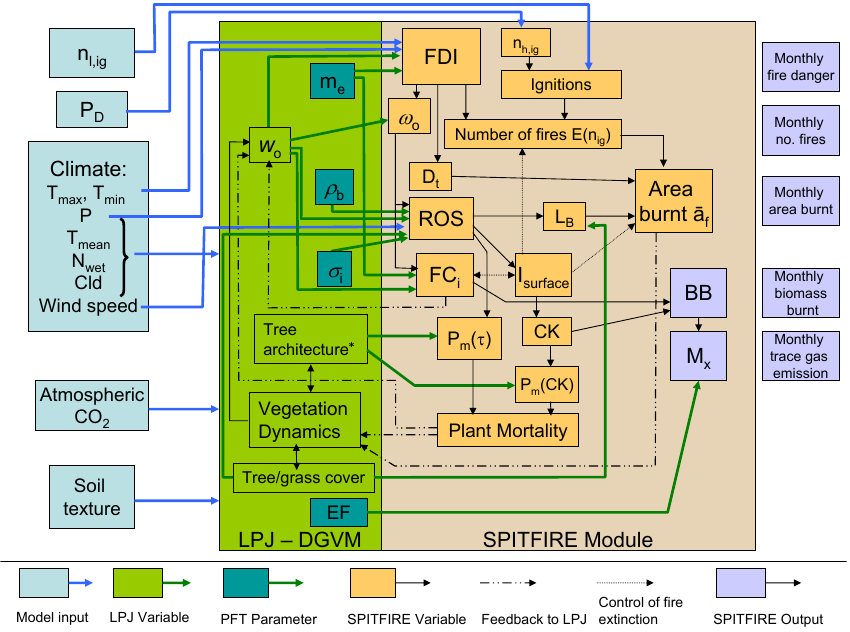
Fig. 2. Systems diagram describing input to LPJ-SPITFIRE, interaction between LPJ and the SPITFIRE module and potential SPITFIRE output variables. Only those LPJ processes, variables or parameter are listed that drive SPITFIRE variables or are influenced by SPITFIRE. Naming of variables follows notation used in the equations in the Methods section, others: P – precipitation, N wet – number of wet days, Cld – cloudiness; * includes PFT-Parameter CL, F, par1 and par2, r(CK) . SPITFIRE output variables other than listed or for a different time period (daily, annually) can be created as well, this is user